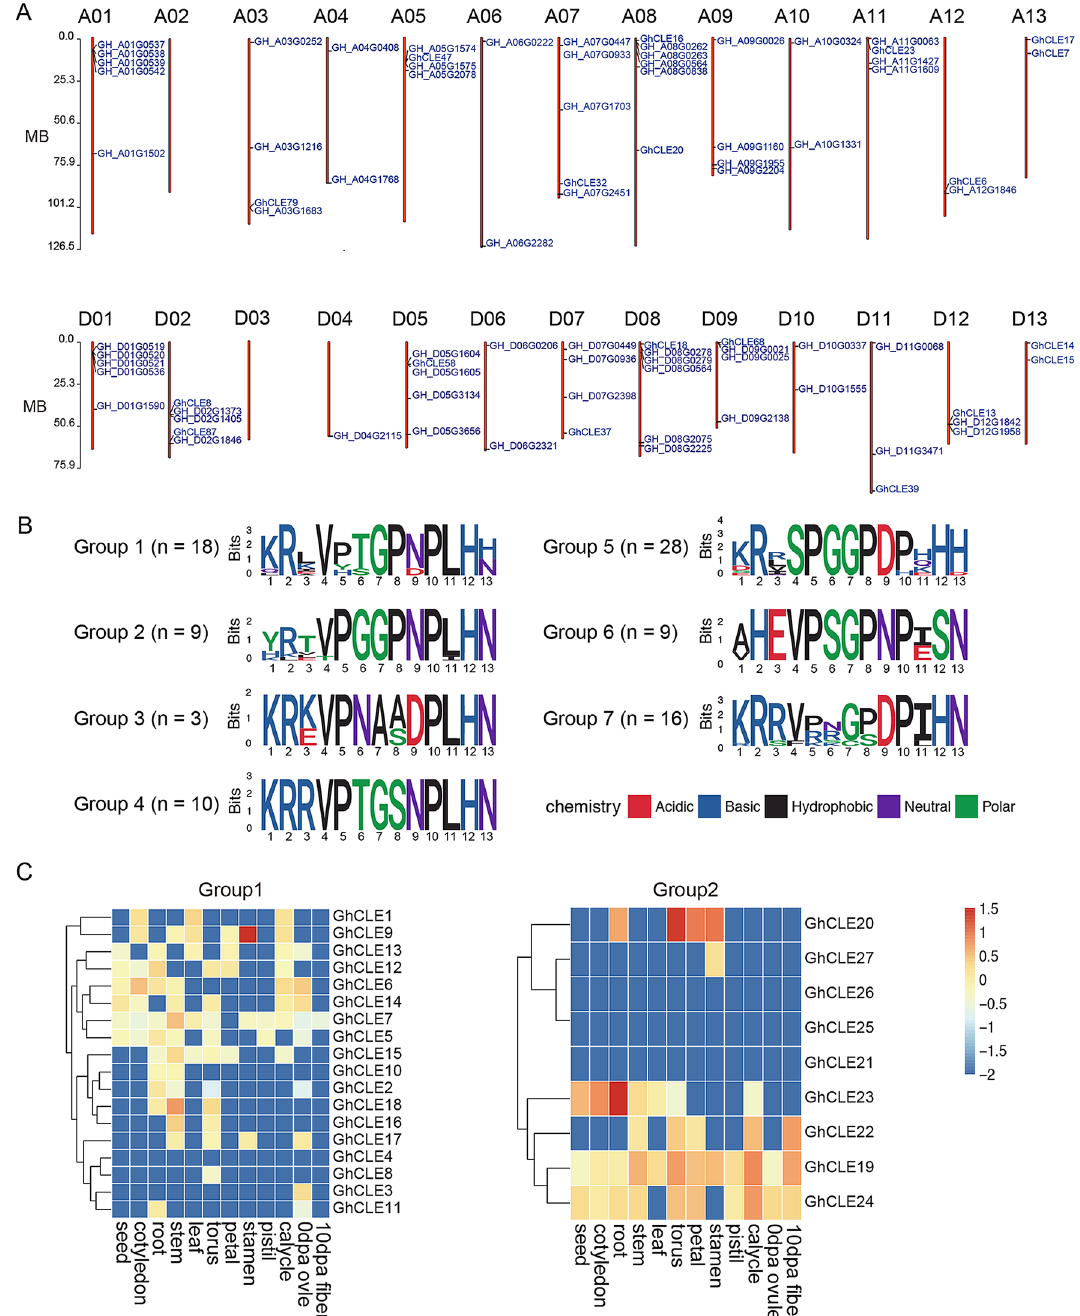
Figure 1. The GhCLE gene family in the upland cotton genome. ( A ) The chromosome distribution of GhCLE genes. A01-13 and D01-13 indicate the chromosome number of upland cotton. The GhCLE genes are labeled on the relative locations on the corresponding chromosome. ( B ) The sequence logos of CLE motif peptides for seven GhCLE gene family groups. ( C ) Heat maps representing the Group 1 and Group 2 GhCLE gene expression patterns in the cotton seed, cotyledon, root, leaf, torus, petal, stamen, pistil, calycle, and ovule tissues 0 day post anthesis (0 DPA) and in 10 DPA